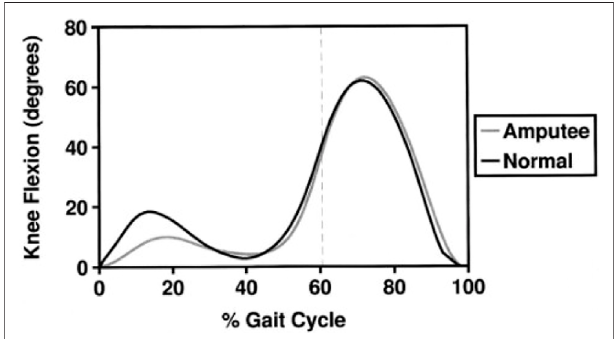
FIGURE1 | Comparison ofknee fl exion between anormal and amputee gait (Powers et al., 1998).